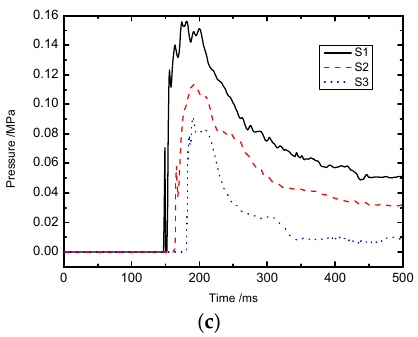
Figure 5. Pressure ‐ time curve on different surfaces. ( a ) Front surface; ( b ) Top surface; ( c ) Side surface.